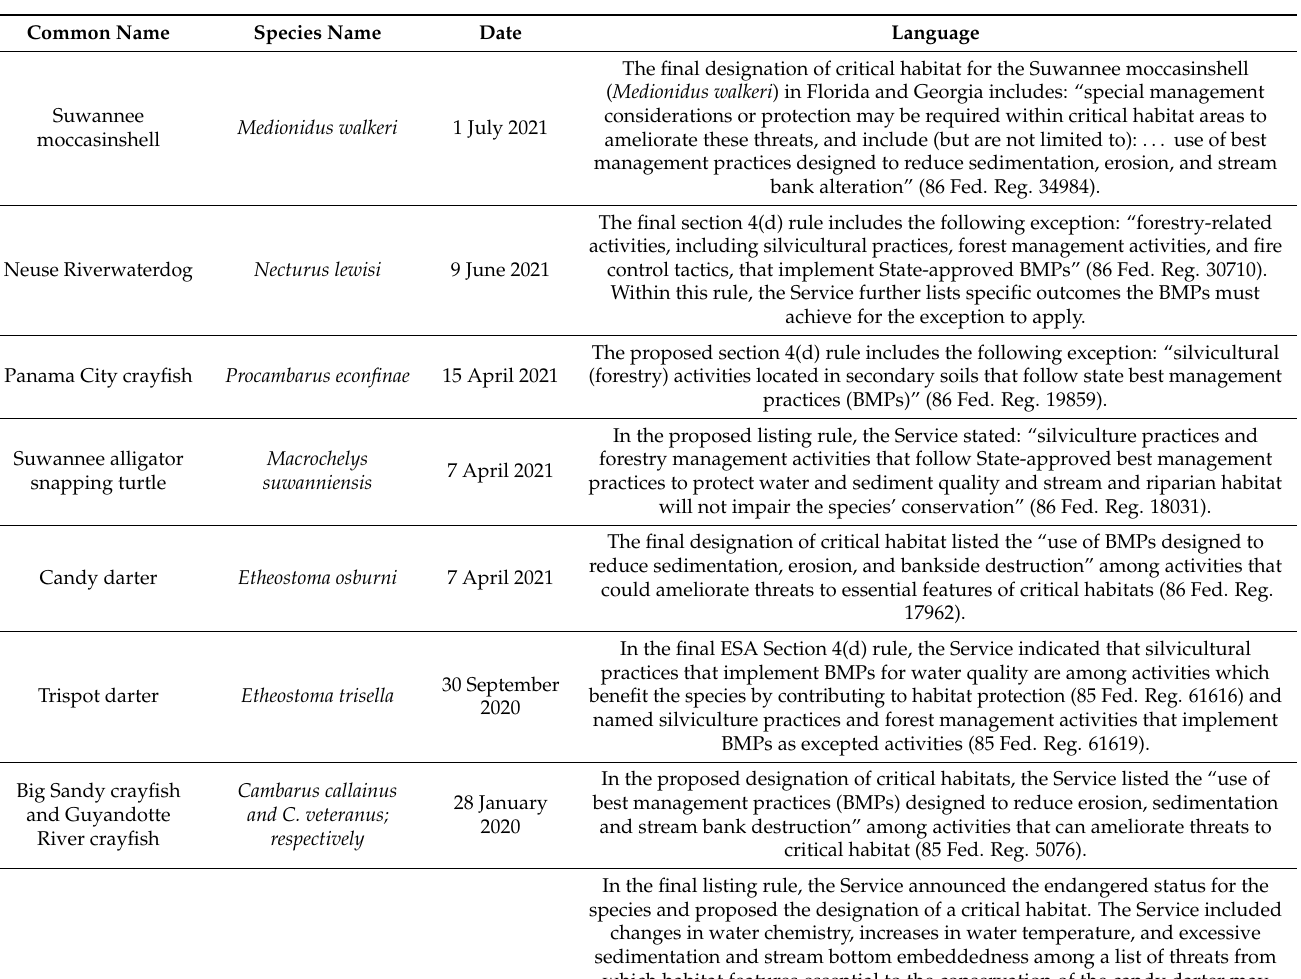
Table 2. Examples of proposed and final rules in which the U.S. Fish and Wildlife Service (Service) has recognized that state-approved forestry best management practices (BMPs) can be an important component of conservation strategies for aquatic organisms. Quoted text was obtained from the Federal Register (Fed. Reg.), which publishes proposed and final federal rulemakings such as Endangered Species Act listing